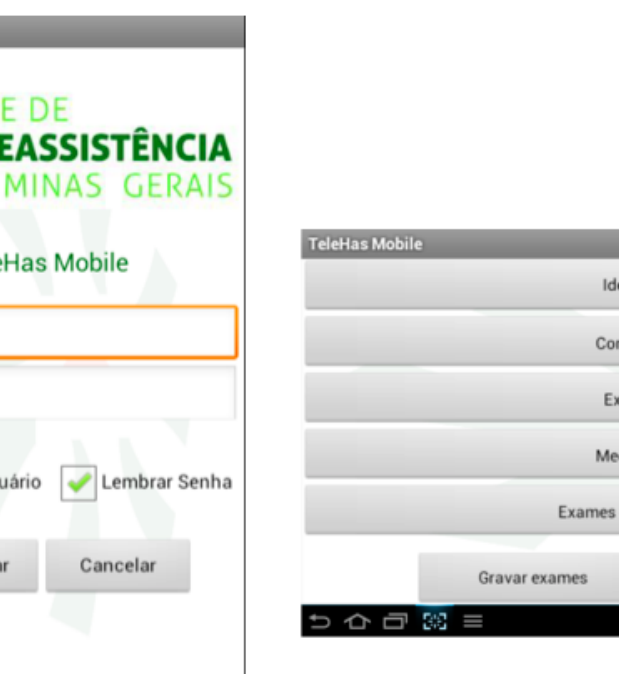
Figure 1. TeleHAS open screen and main